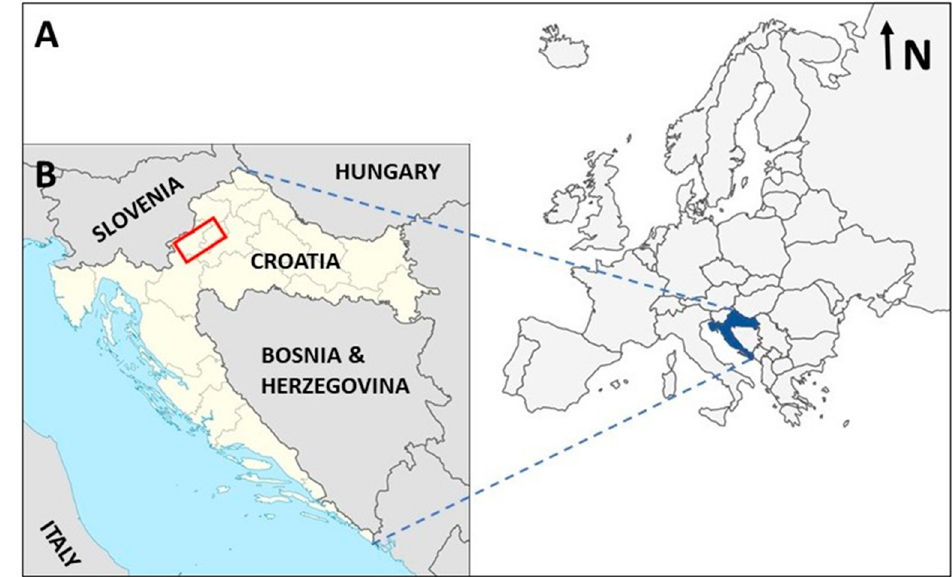
Figure 1. Map of the study area, its geographical position ( A ), and sampling area ( B ). A total of 19 samples, representing 15 edible mushroom species from the phylum Basidiomycota, were collected and analyzed for total element concentration (Table 1).